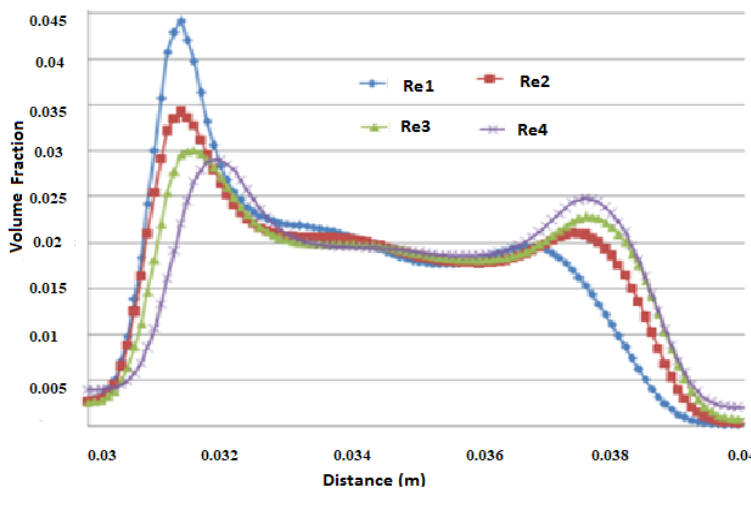
Figure 4. Variation of solid phase volume fraction (for W 9 slurry) for different slurry velocities at constant